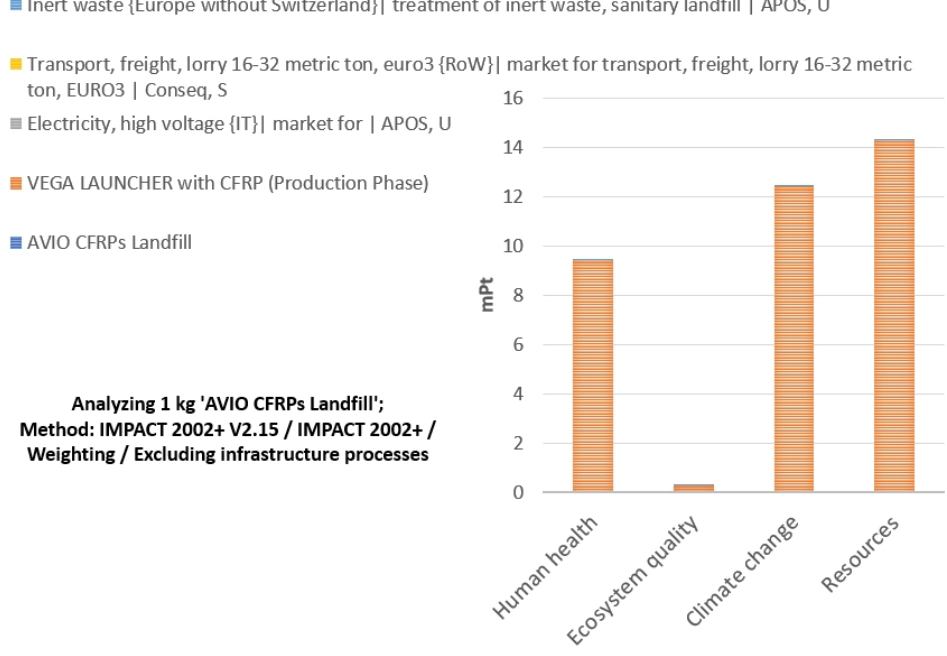
Figure 10. Results of landfill into endpoint categories.